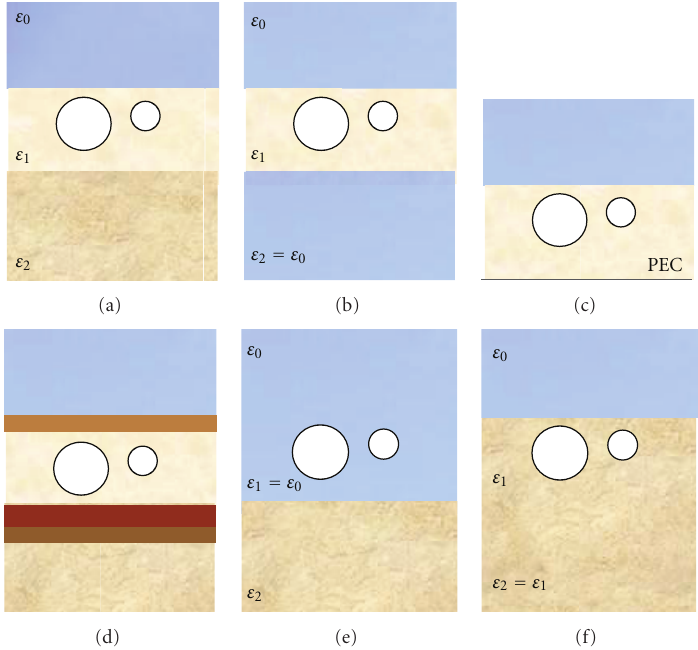
Figure 3: Cylinders in a finite-thickness slab, various scenarios.